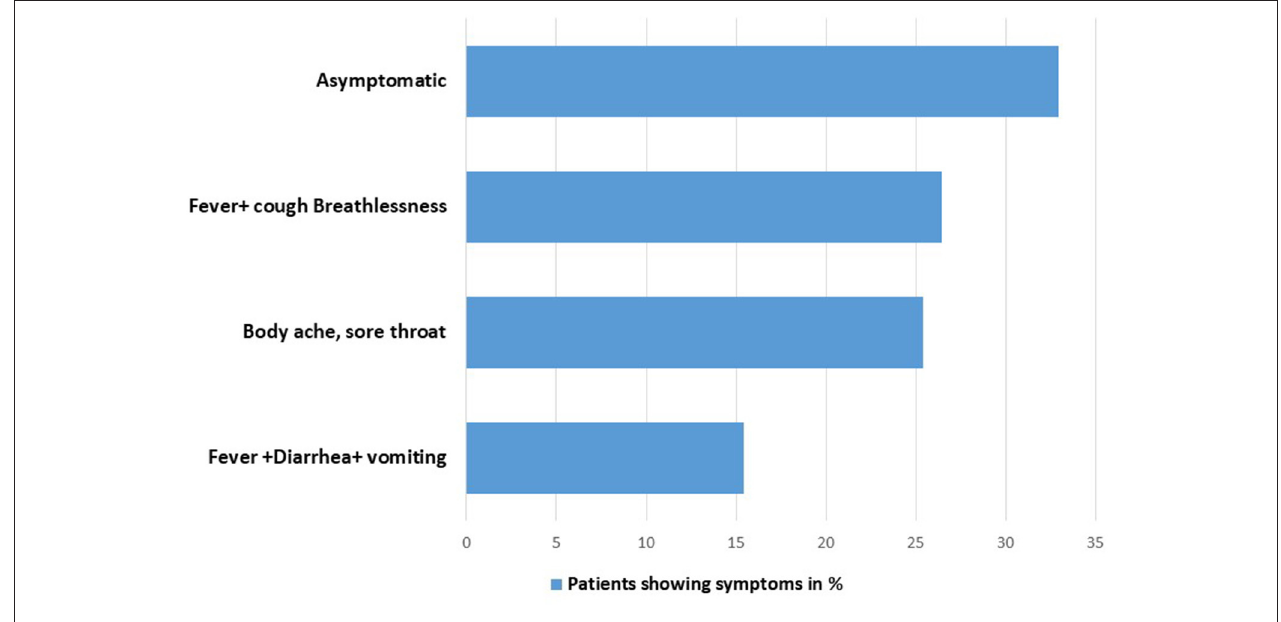
FIGURE 1 | Symptomatic characteristics of enrolled patients.